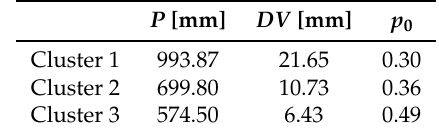
Table 3. Mean values of annual precipitation sum ( P [mm]) for each cluster, average deficit volumes DV [mm] for each cluster and probabilities p 0 of year without drought event per